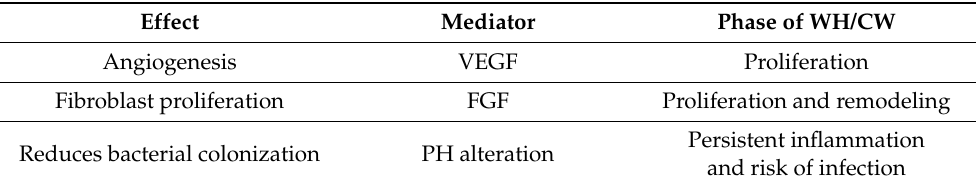
Table 8. Beneficial effects reported of electrical stimulation (ES) in wound healing (WH) and chronic wound (CW). Effect Mediator Phase of WH/CW Angiogenesis VEGF Proliferation Fibroblast proliferation FGF Proliferation and remodeling Persistent inflammation Reduces bacterial colonization PH alteration and risk of infection